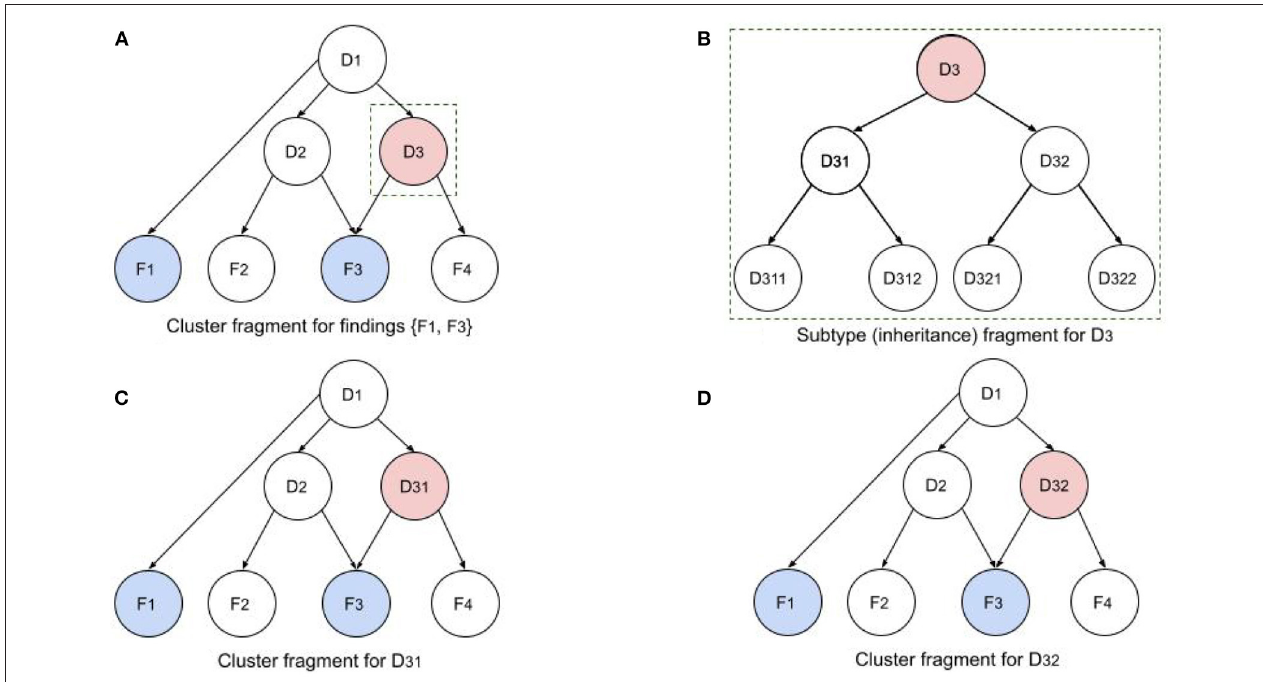
FIGURE 4 | Illustration of recursive BN computations for disorder cluster and subtype fragments. (A) Cluster fragment for patient findings F 1 and F 3 and disorder subtype ancestors. (B) Subtypy tree for disorder D 3 . (C,D) D 3 in original network has been replaced by its children D 31 and D 32 to compute the cluster probabilities with the two